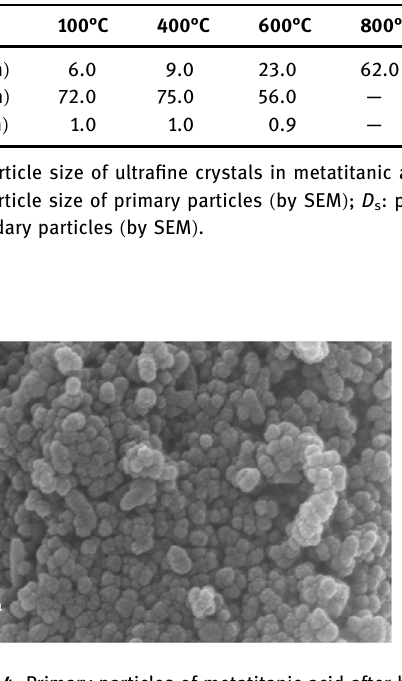
Figure 4: Primary particles of metatitanic acid after heating treat - ment at 750°C.